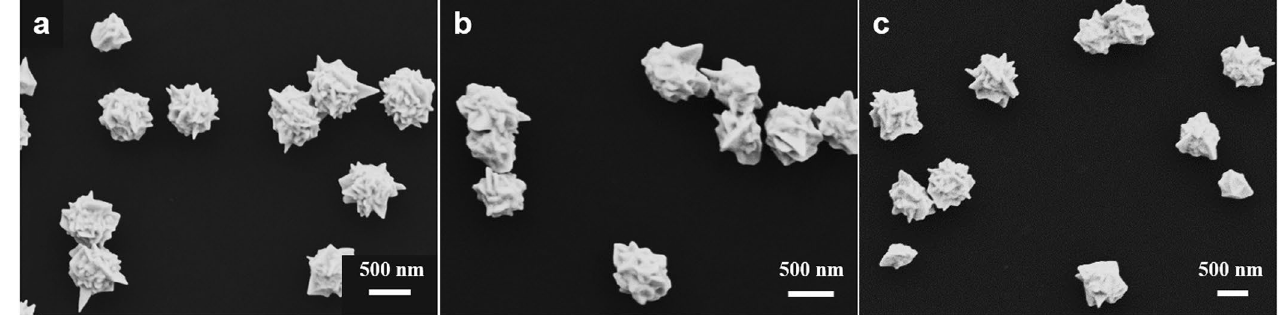
Figure 7. FESEM images of prepared AuPt nanoparticles at ( a ) 40 °C, (b) 50 °C and (c) 60 °C.